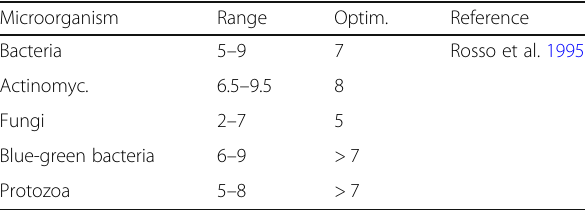
Table 1 Maximum, minimum, and optimum pH values for microorganisms Microorganism Range